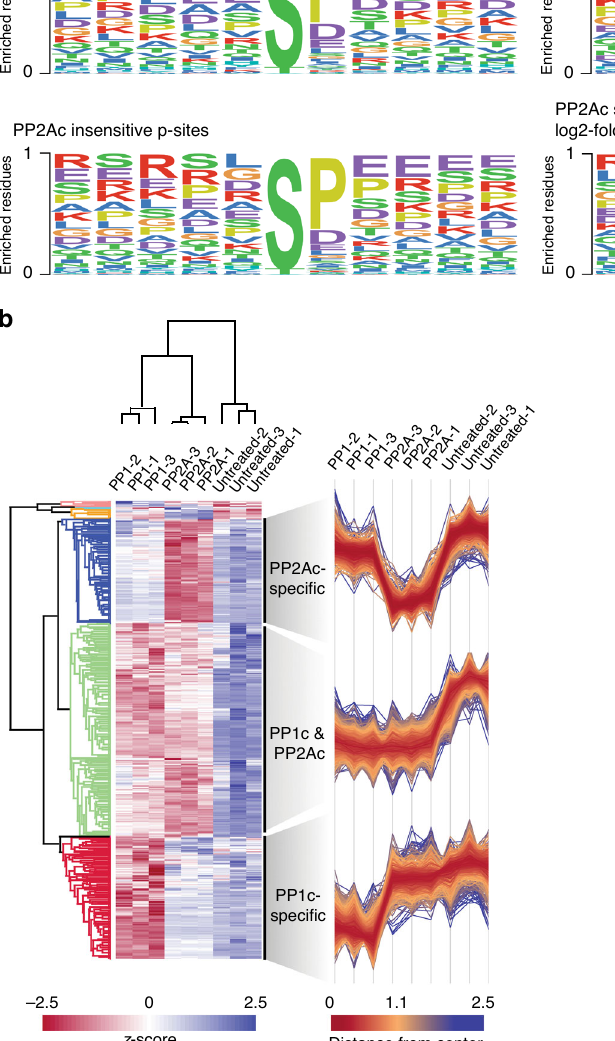
PP2A holoenzymes are also known to regulate 14-3-3-binding sites 36,40 – 42 . To further strengthen the fi ndings on this distinct intrinsic motif af fi nity for PP1c, we analyzed all p-sites by hier- archical clustering (Fig. 5b). This analysis revealed three major clusters, of which one contained 1361 sequences depho- sphorylated by both PP1 and PP2A, the second 777 PP1c-speci fi c sequences, and the third 663 PP2Ac-speci fi c sequences (Supple- mentary Data 2). Accordingly, about 48% of the substrates were dephosphorylated by PP1c and PP2Ac, 28% were speci fi c to PP1, and 24% speci fi c to PP2A. Among p-sites differing with statistical signi fi cance between PP1c/PP2Ac, we found 12 RXXpS- containing p-sites on Ser/Arg-rich splicing factors (SRSFs) and